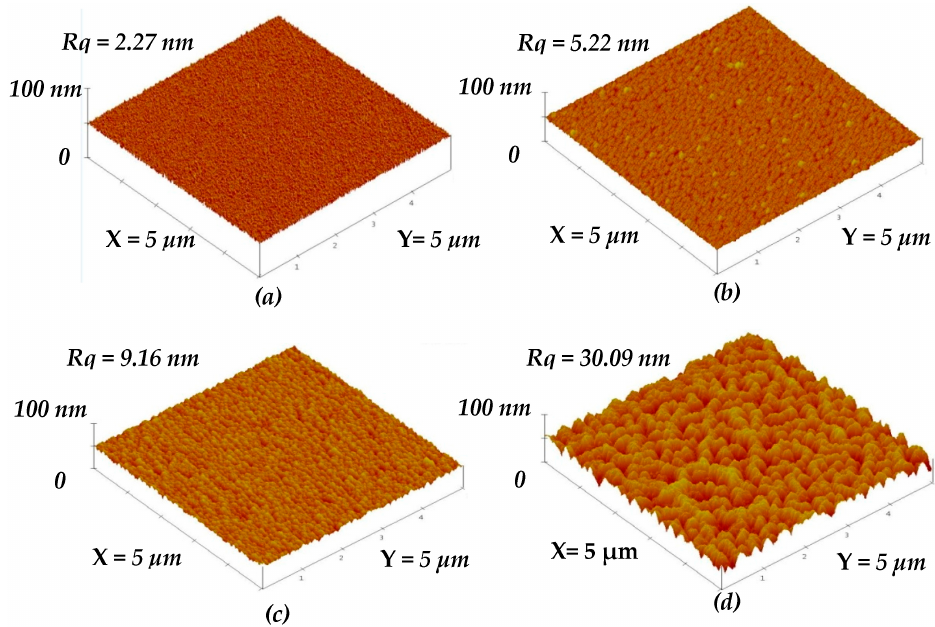
Figure 4. Surface roughness of the a-TiO x film deposited onto ( a ) untreated base layer; and SFE-treated base layers for ( b ) 10; ( c ) 20; and ( d ) 35 s; respectively.